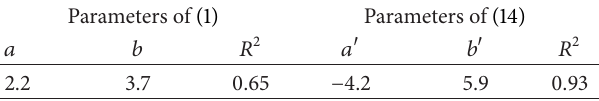
Table 2: Parameters of (1) and (14) obtained from linear regression of the experimental data presented in Figures 4(a) and 4(b),